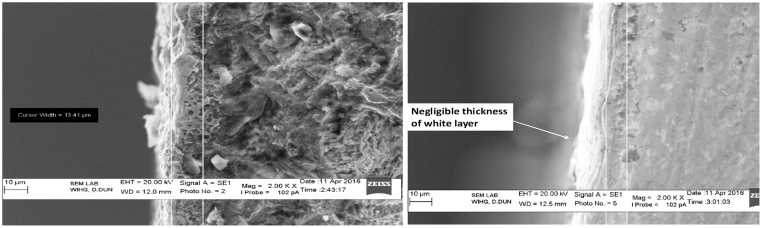
(a) White layer thickness for trial 1st (b) White layer thickness for the trial 7th.